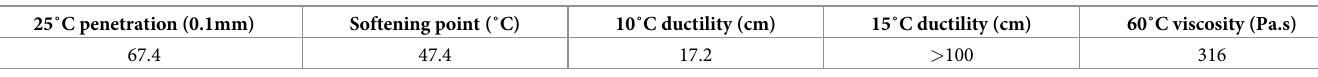
Table 1. Technical properties of the base asphalt binder.